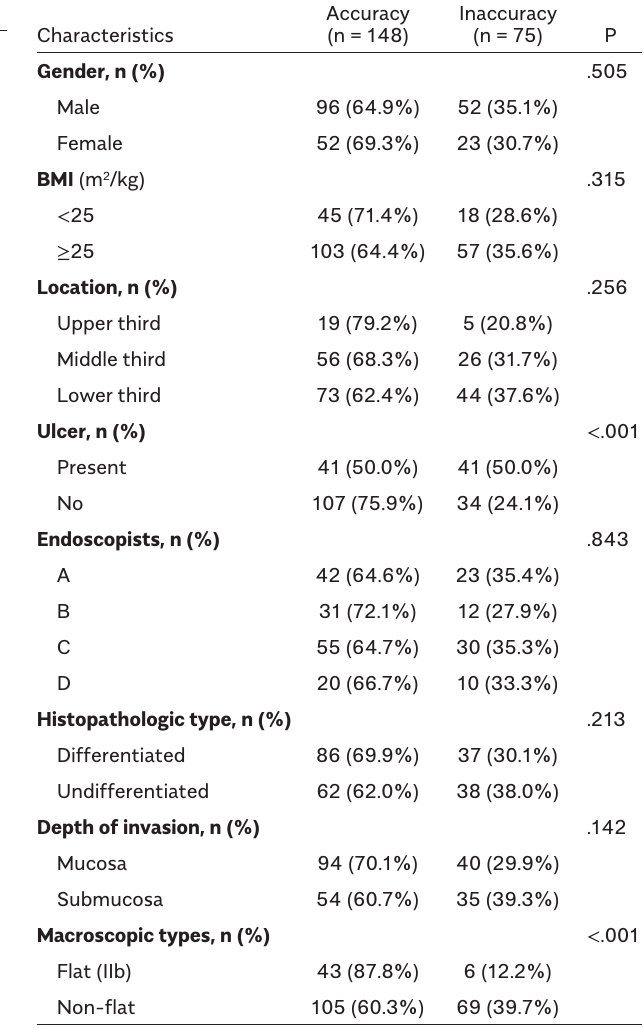
Table 2. Clinical Factors Affecting the Accuracy of EUS for the Depth of Invasion (n = 223)